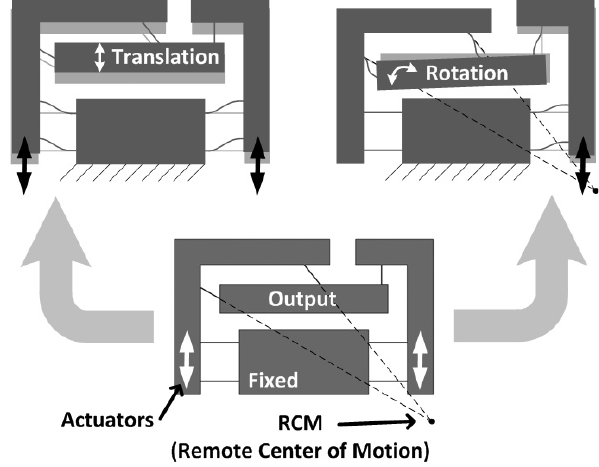
Figure 4. Principle of the designed active T k R ⊥ brick: the syn- chronous motion of the actuators performs the translation, while the rotation around the RCM results from their di ff erential displace-